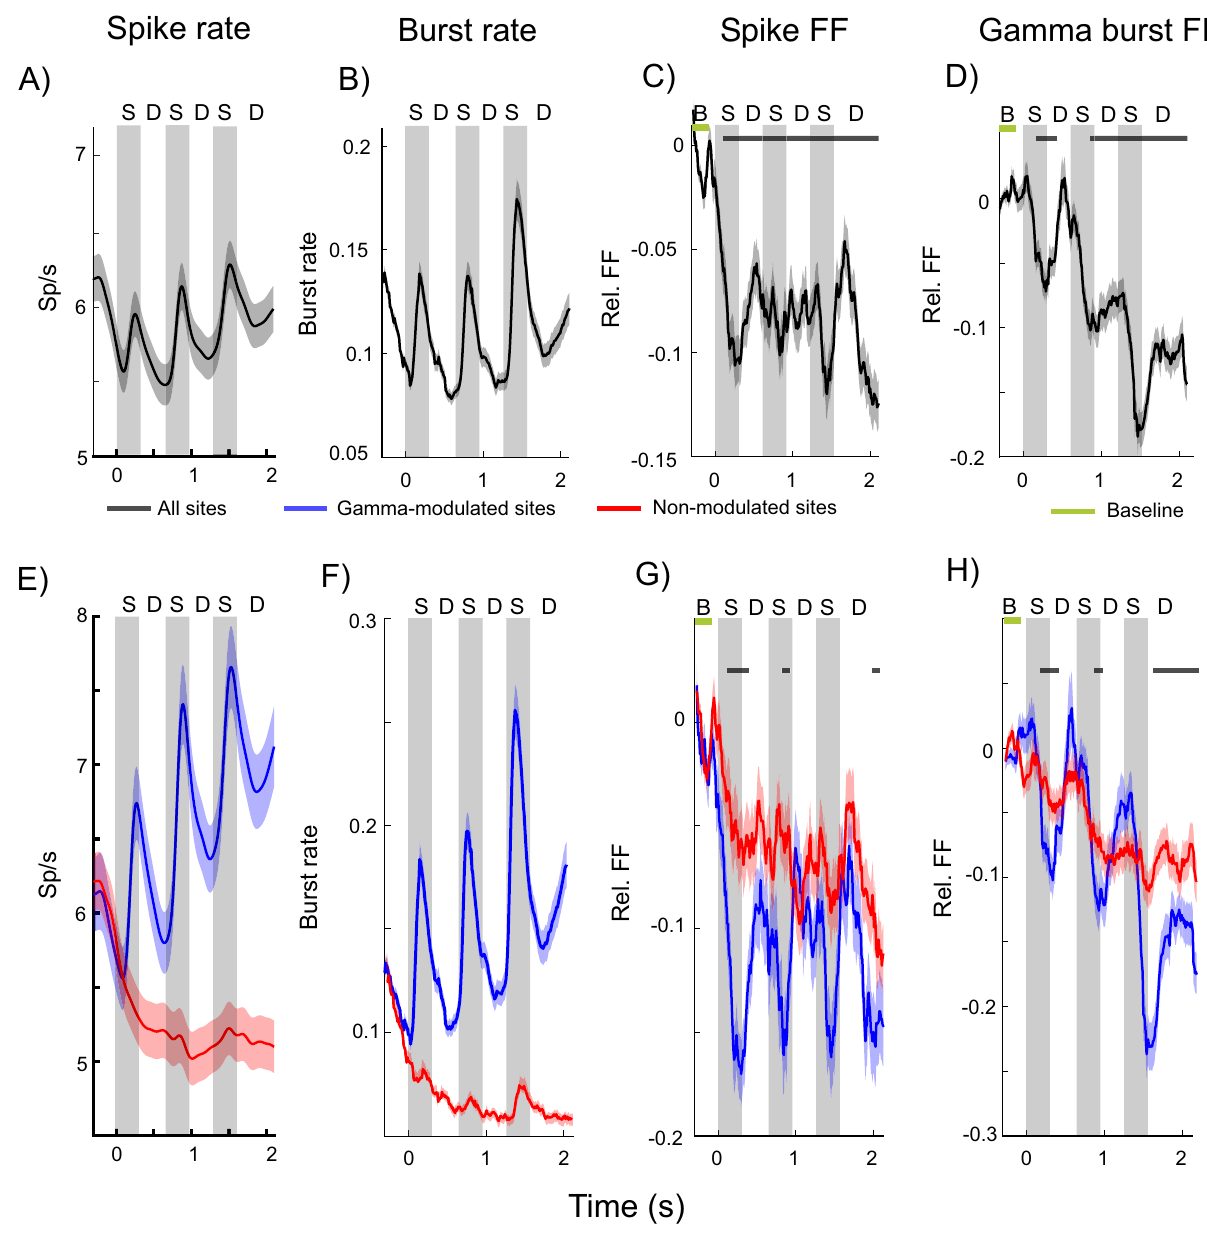
Figure 2. Spike and burst variability in Task 1. ( A ) Spike rates averaged across trials and all neurons (n = 495). Gray shaded regions indicate sample presentations (S; the first sample is presented at time = 0). The three delays are marked by “D”. Error bars indicate standard error of the mean in all panels. ( B ) Gamma burst rates averaged across trials for all recording sites (n = 319). ( C ) Relative FF in spike times, i.e. normalized by the pre-stimulus baseline (marked by “B”; from 300 to 100 ms prior to first sample onset) average. ( D ) Relative FF in burst times (normalization as in ( C ). Black bars indicate time periods when post stimulus FF deviated significantly from the pre-stimulus baseline (marked by the green bar, p < 0.0001, permutation-based cluster statistics 49 ). ( E–H ) same as ( A–D ) but separately for sites that increased (blue; n = 145 sites and n = 214 neurons) gamma bursting at sample onset, and sites that did not (red; n = 174 sites and n = 281 neurons). Black bars indicate time periods when blue and red curves are significantly different (p < 0.03 permutation-based cluster